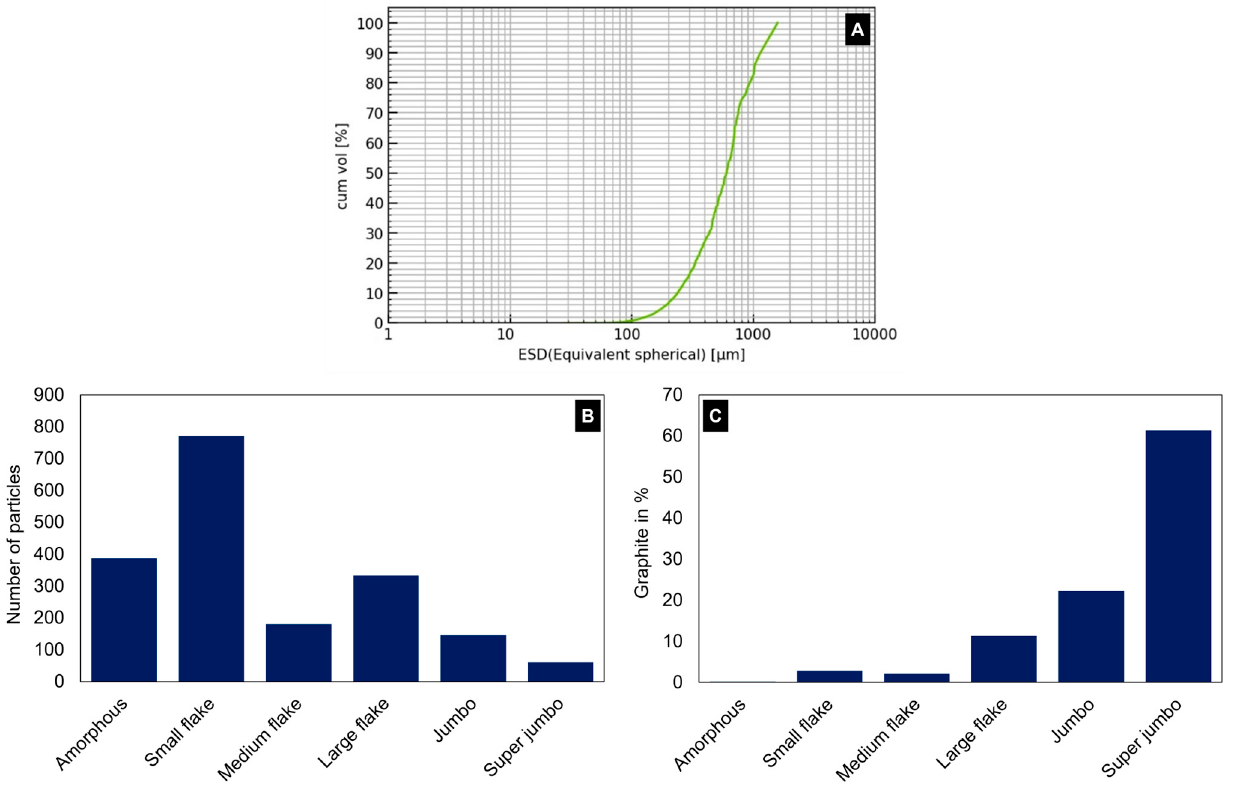
Figure 7. Distribution of graphite types according to CT measurements. ( A ) Cumulative particle analysis, ( B ) number of particles corresponding to each class and ( C ) volumetric proportion of each class in the sample. Table 5. Properties of the graphite classes determined.